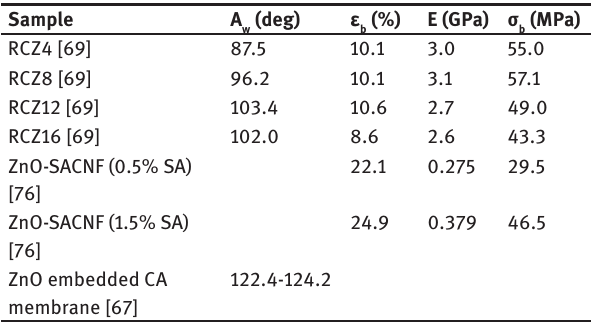
, ε , E, σ properties of the cellulose/ZnO. W b b